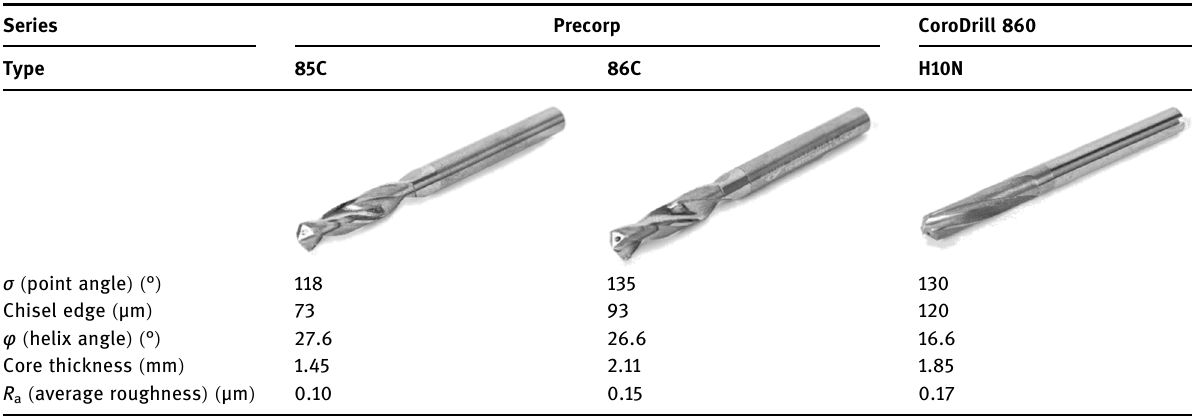
Table 2: Sandvik ® drill tools speci fi cations